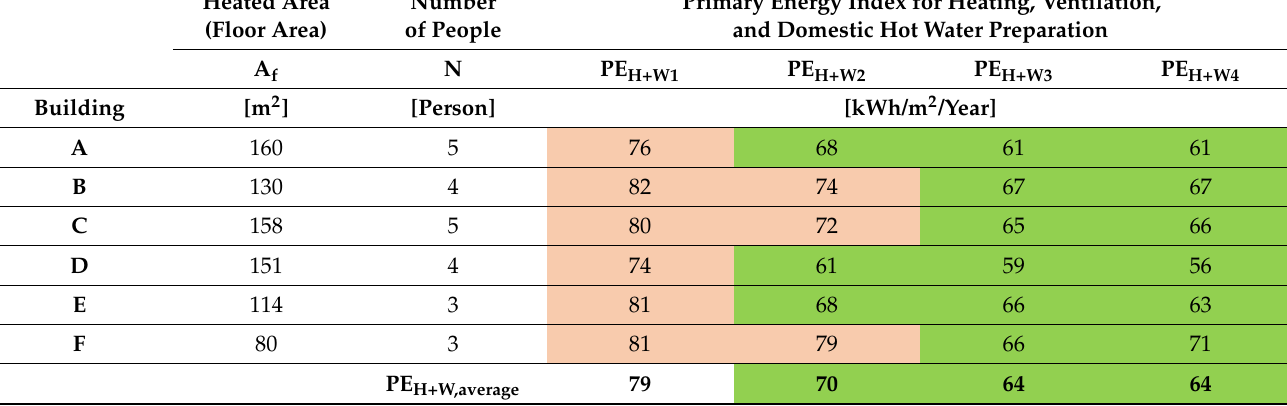
Calculated primary energy indicators obtained by applying various DHW consumption indicators for new